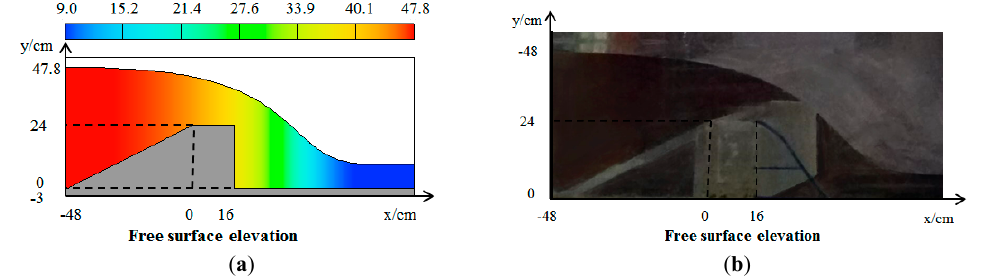
Figure 5. Comparison of free surface profiles for S 1 = 2.0, S 2 = 0.0 at ξ = 0.6: ( a ) simulated results; ( b ) laboratory results.